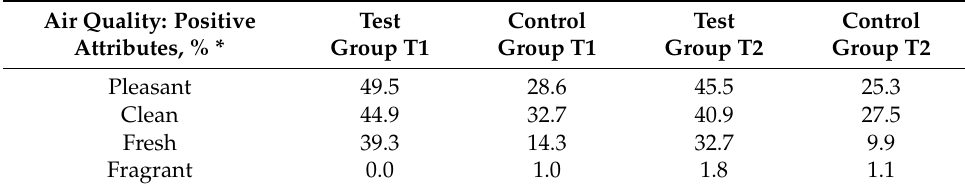
Table 5. Positive perception of indoor air quality in both groups at T1 (three months after moving in) and T2 (one year later).